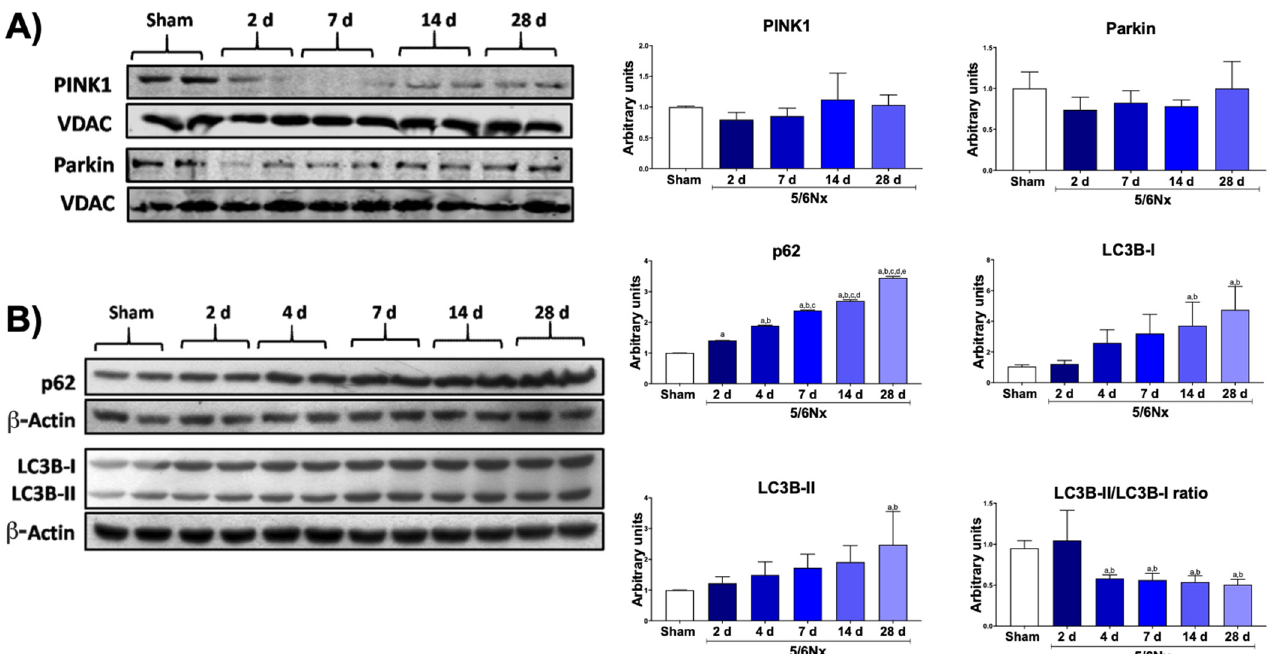
Figure 5. Alteration in mitophagy and autophagy markers in remnant mass. ( A ) Western blots and their quantifications of mitophagy proteins: phosphate and tensin homolog (PTEN)-induced kinase 1 (PINK1) and PARKIN in isolated mitochondria. Voltage-dependent anion channel (VDAC) was used as loading control. ( B ) Western blots and their quantifications of autophagy proteins: p62 and microtubule-associated proteins 1A/1B light chain 3B I and II (LC3B-I/II). β -Actin was used as loading control. Data are the mean ± SEM, n = 4. Tukey test. a = p ≤ 0.05 vs. sham, b = p ≤ 0.05 vs. 2 days, c = p ≤ 0.05 vs. 4 days, d = p ≤ 0.05 vs. 7 days, e = p ≤ 0.05 vs. 14 days, 5/6Nx = 5/6 nephrectomy, d = days after 5/6Nx, sham = simulated operation/control group.